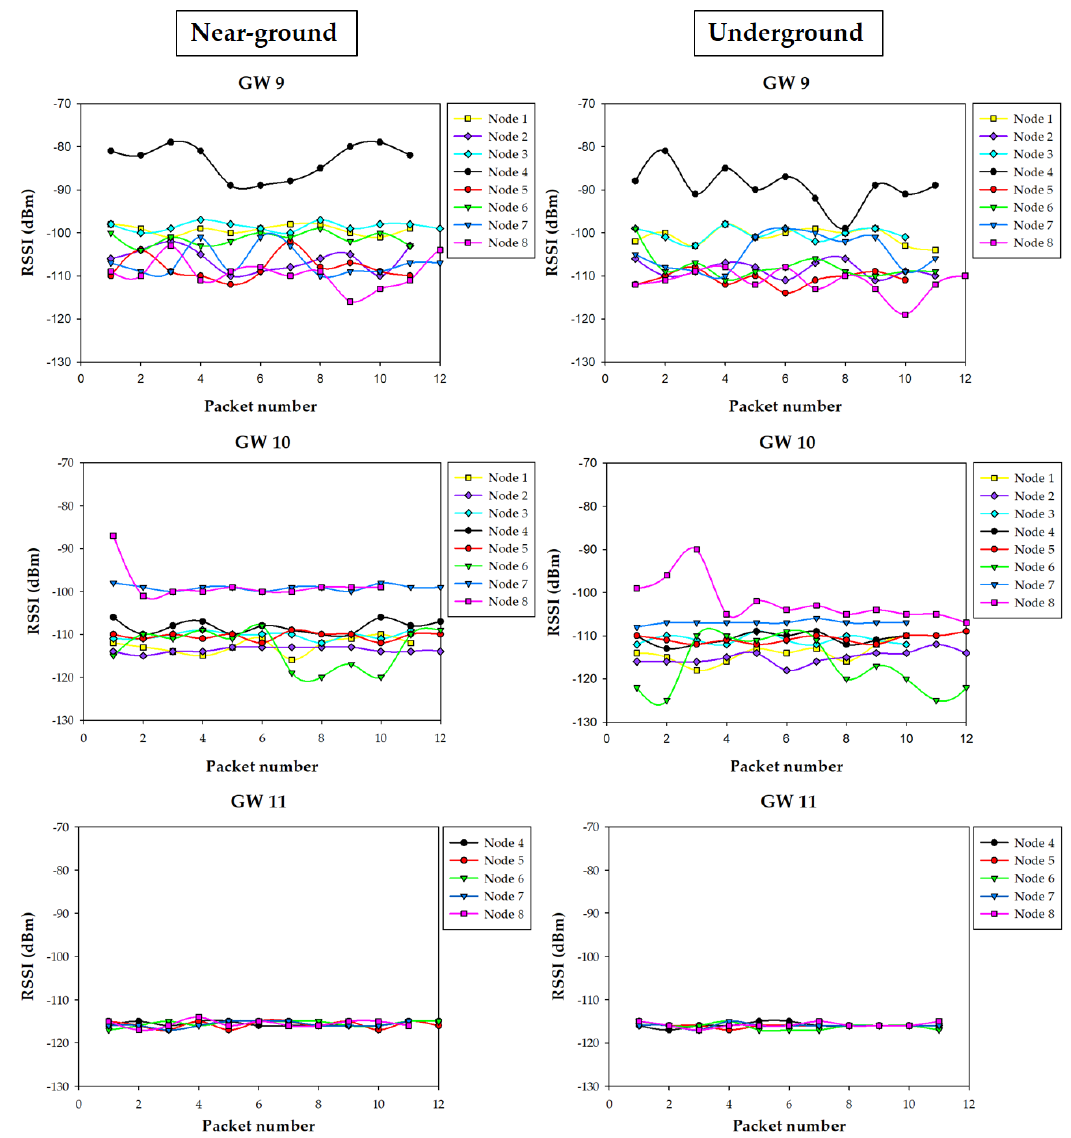
Figure 20. Summary of the measurements at 433